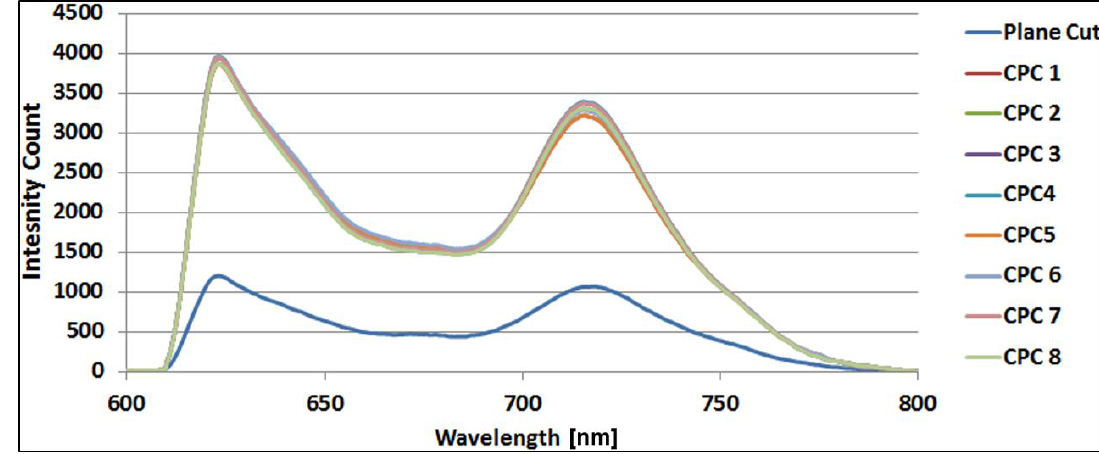
Figure 7. Spectrum for plane-cut and CPC fiber tips for dummy sensor.